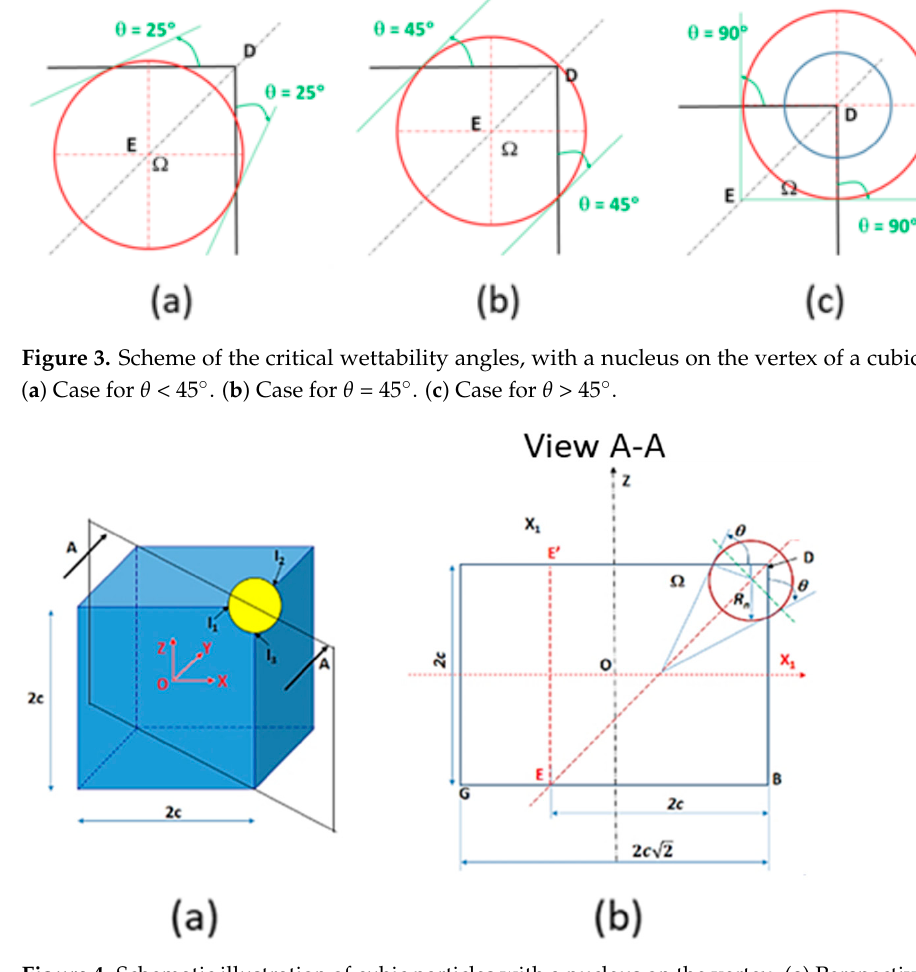
Figure 4. Schematic illustration of cubic particles with a nucleus on the vertex. ( a ) Perspective view of nucleus growth in the corner of the cubic particle; ( b ) Section view (A-A) for the geometric derivation of model volumes and surfaces for this section.